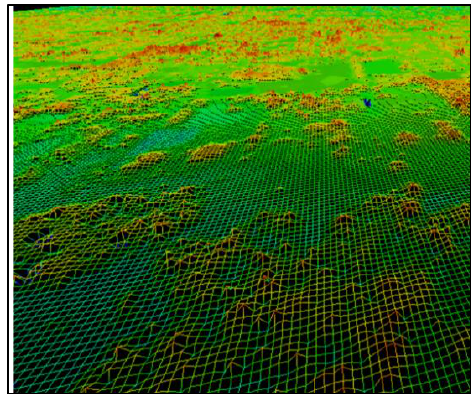
Figure 1. Sparse LiDAR Points in 3D View